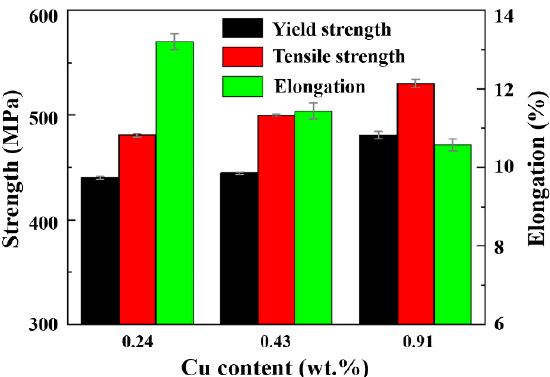
Figure 2. Yield strength, tensile strength, and elongation of Al-5Zn-2.6Mg-xCu alloys as a function of Cu content.